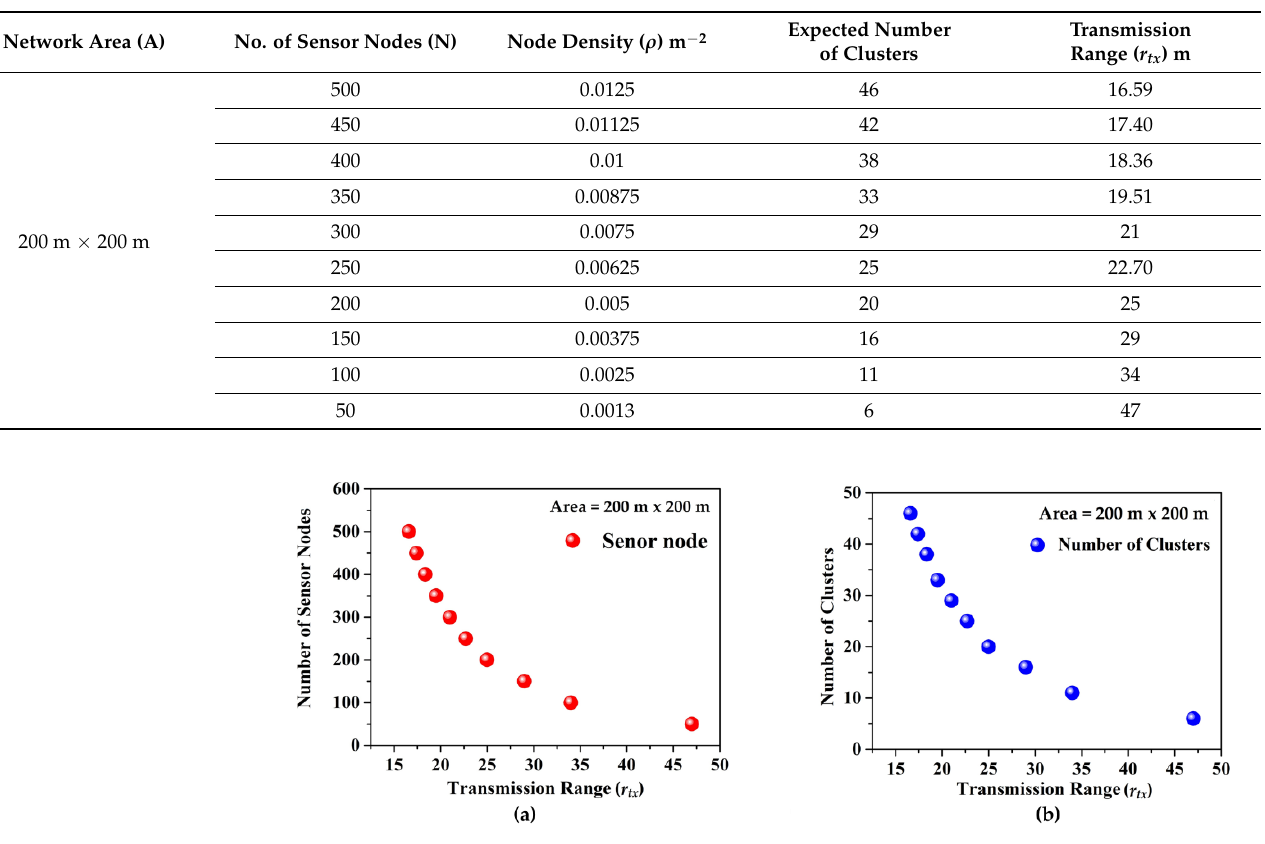
Table 5. Transmission range for a fixed network area and different node densities. (Probability of connectivity is 0.99).